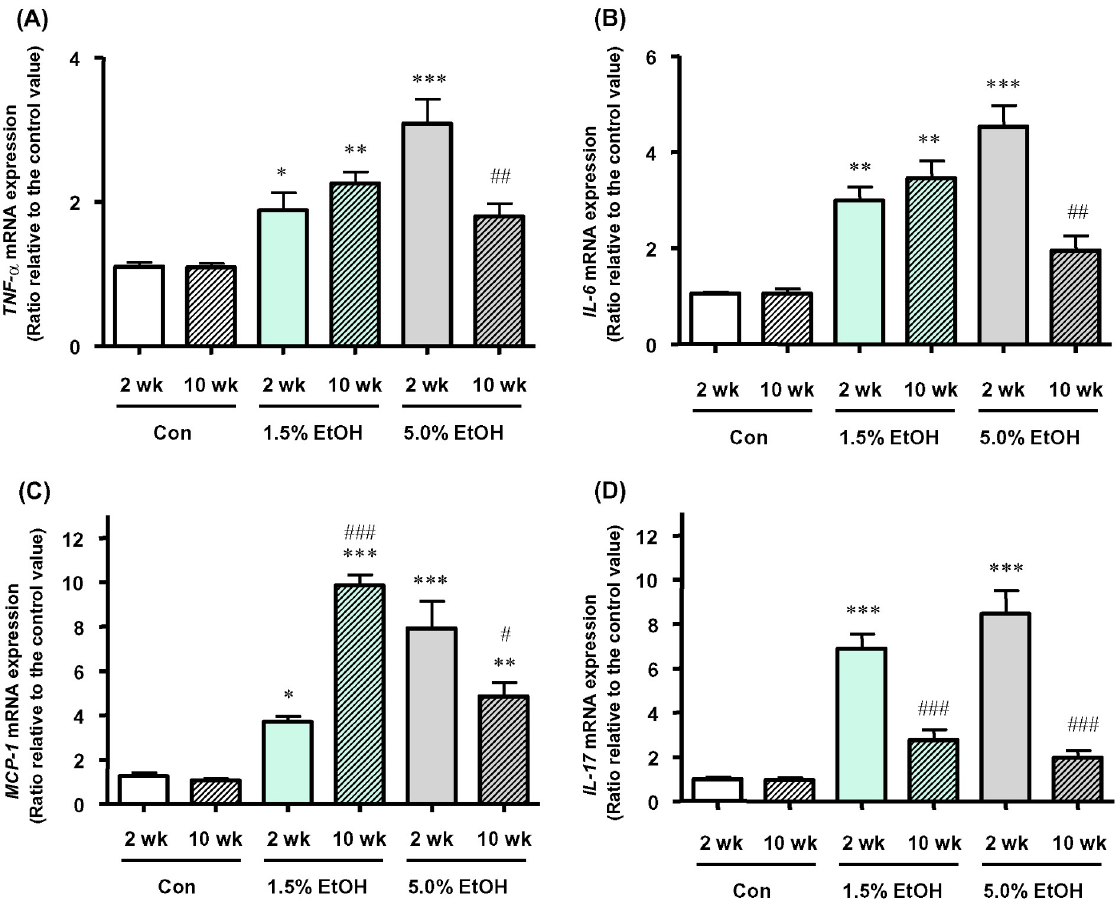
Fig 4. Effects of chronic oral administration of ethanol on colonic mRNA levels of inflammatory marker proteins in mice on qRT-PCR. The mRNA levels of (A) TNF- α , (B) IL-6 , (C) MCP-1 , and (D) IL-17A are shown as relative values with the respective mRNA level of a 2-wk Con subject taken to be 1.0 and expressed as the mean ± SD (n = 5). � p < 0.05, �� p < 0.01, and ��� p < 0.001; versus 2 wk Con as assessed by ANOVA with the Tukey-Kramer test. # p < 0.05, ## p < 0.01, and ### p < 0.001; 2 wk versus 10 wk within the same ethanol dosage, as assessed by the paired t -test. For abbreviations for ethanol-administration conditions, see the legend to Fig 2.